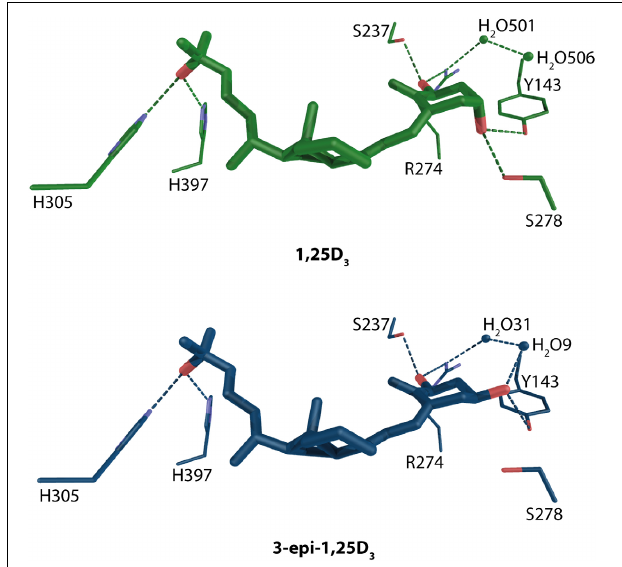
FIGURE 4 | Binding mode of 1 α , 25-dihydroxyvitamin D 3 and 3-epi-1 α ,25-dihydroxyvitamin D 3 in the LBP of human VDR (source PDBID: 1DB1 and 3A78). 1,25D 3 and 3-epi-1,25D 3 are highlighted in green and blue color, respectively. The hydrogen bonds are in green and blue dashed lines.